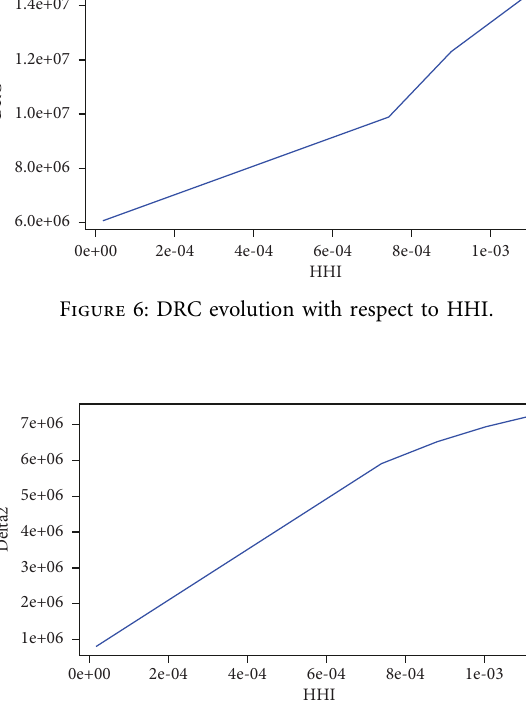
Figure 7: Δ 2 q evolution with respect to HHI.